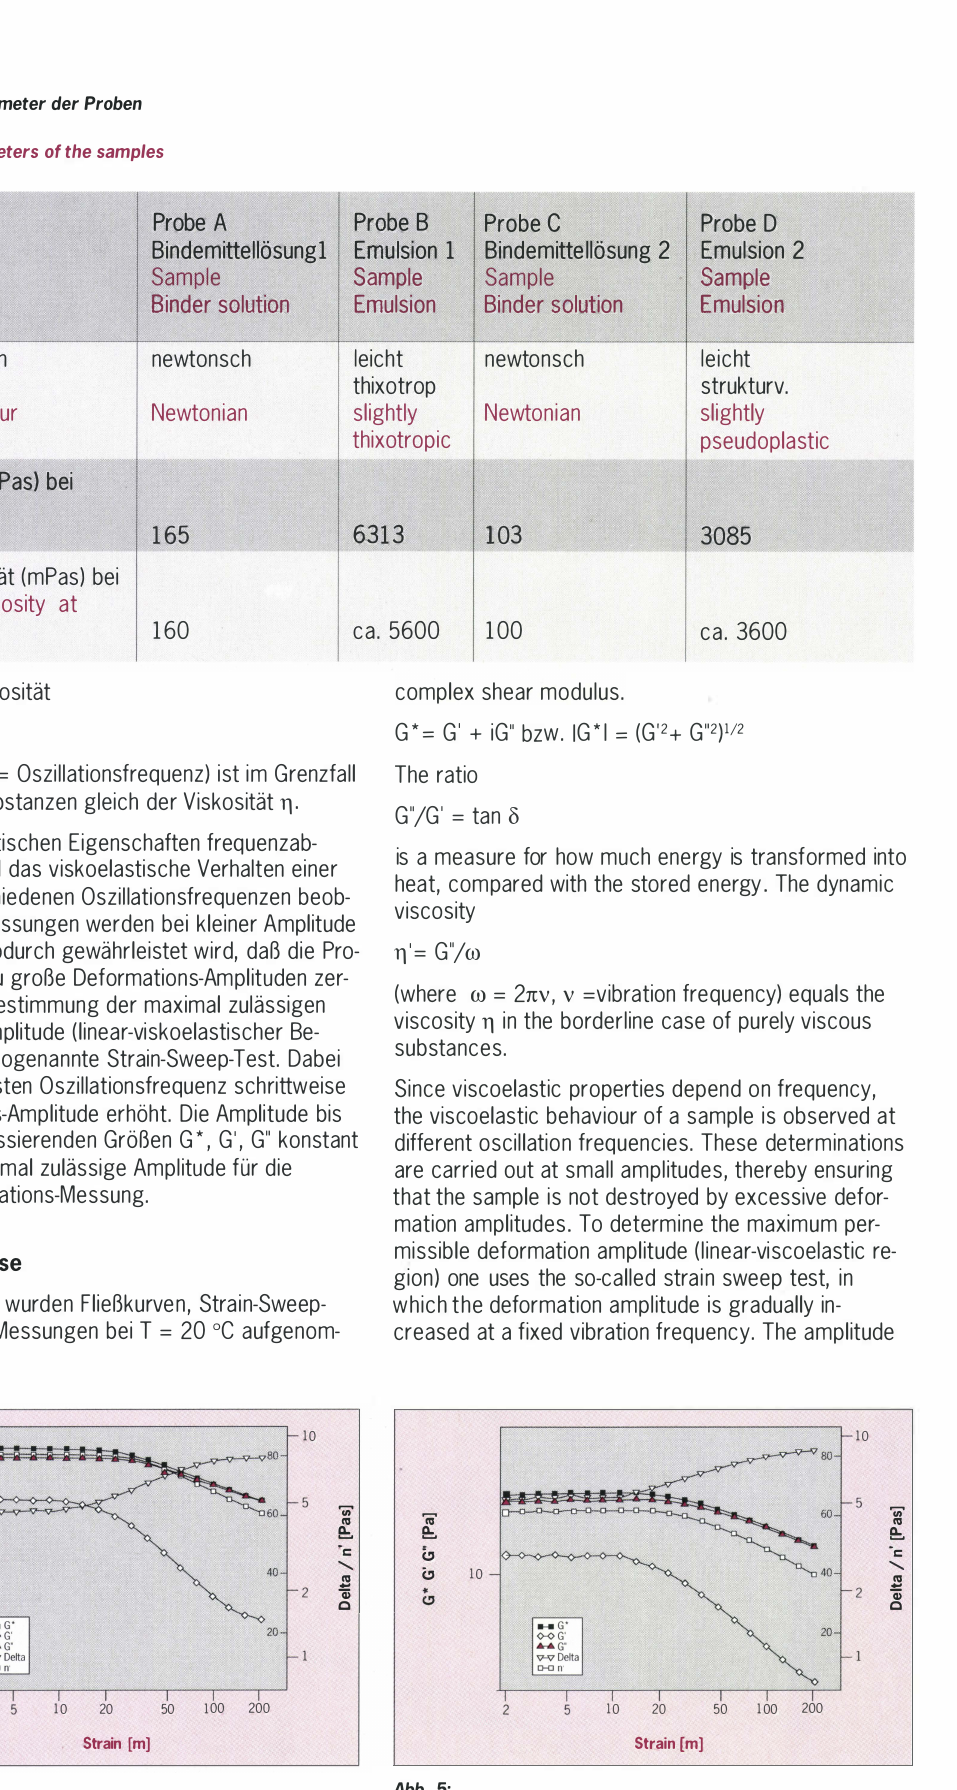
Fig. 5: Strain sweep test for emulsion 2 (sample